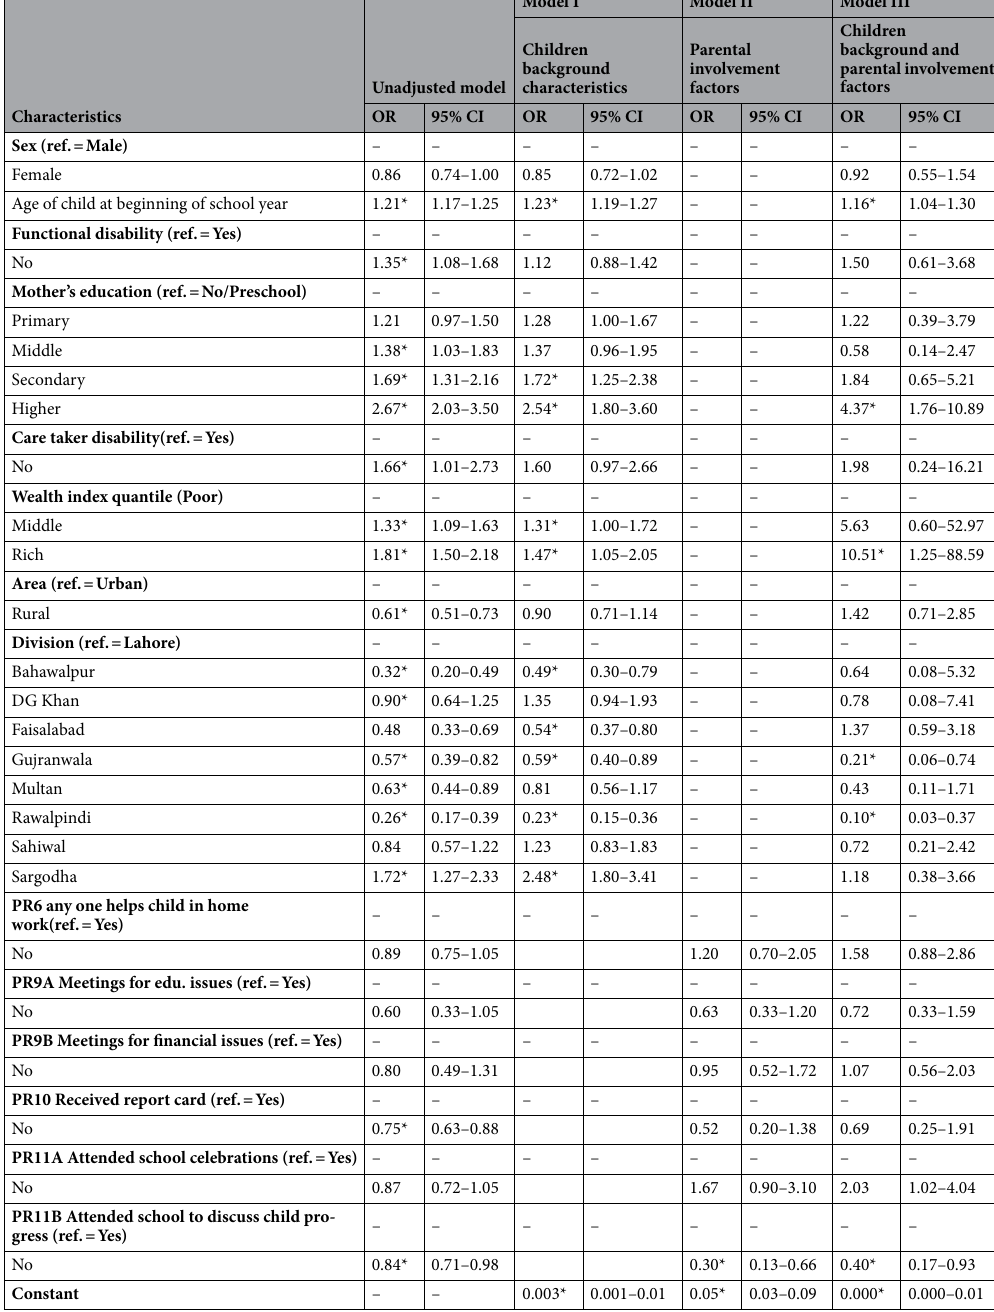
Table 4. Odd Ratios of Children Background Characteristics and Parental Involvement Factors on Foundational Numeracy Skills using Logistic Regression, MICS Punjab 2018. *Significant at 5%, Model I, II and III are adjusted